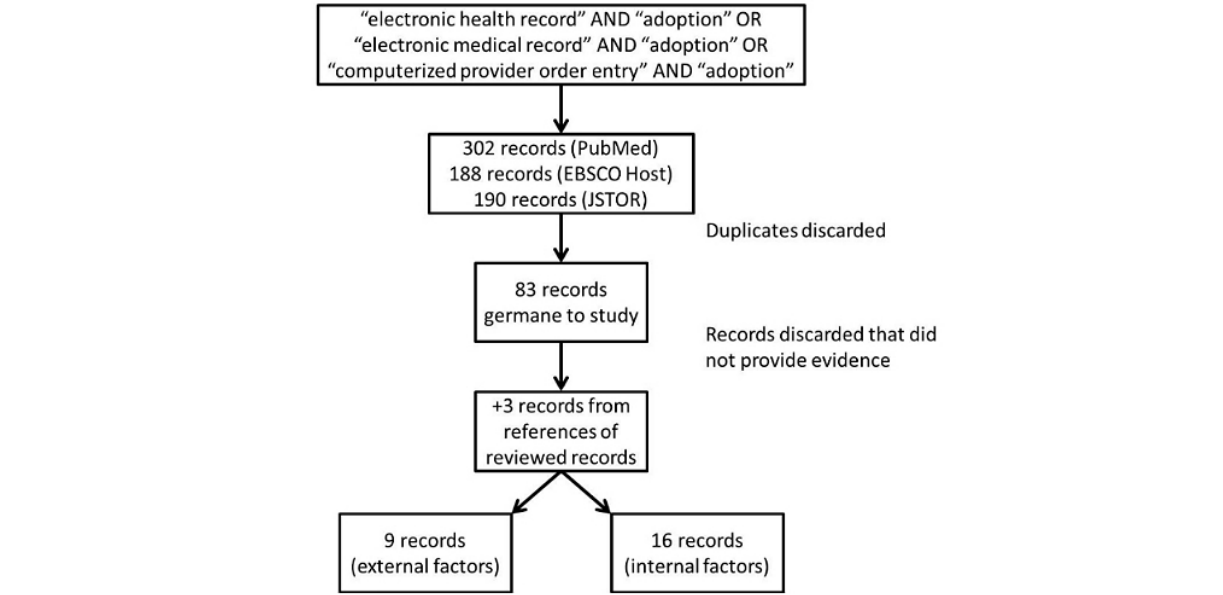
Figure 1. Literature review